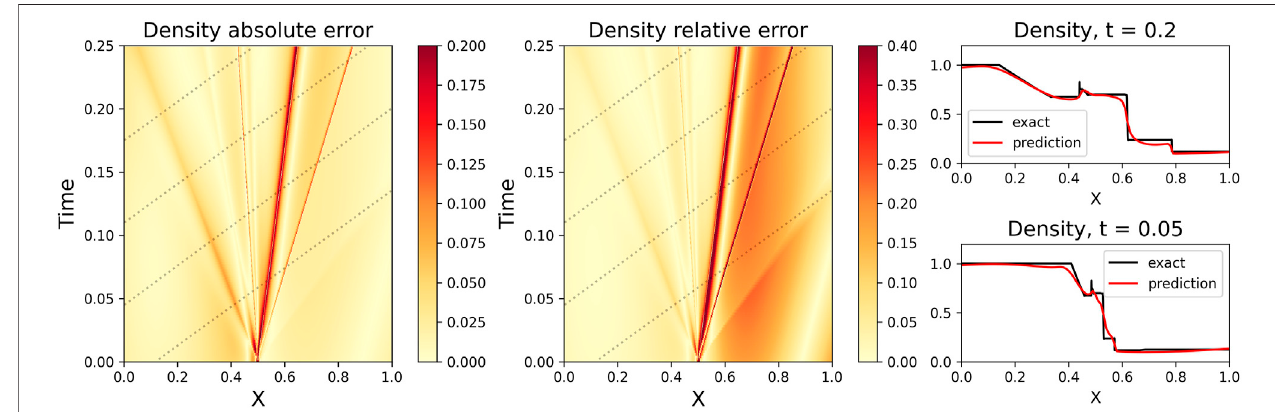
FIGURE10| Sameas Figure7 ,exceptwith ] (cid:1) 0.01andwithrandomGaussiannoiseaddedtothedata(c.f. Figure9 ).TheDensityabsoluteerror (cid:3) ρ net − ρ (cid:3) isalso plotted. Despite the noise, the PINN obtains a similar reconstruction as the noiseless state, with similar issues around shocks and further from the constraining data. Althoughtherelativeerrorishigher ontherightsideoftheshock,theabsoluteerrorisofthesameorderoneithersideofthereconstruction.Since thePINNlossfunction uses MSE, it minimizes the absolute error without regard to the relative magnitude difference of the actual value.